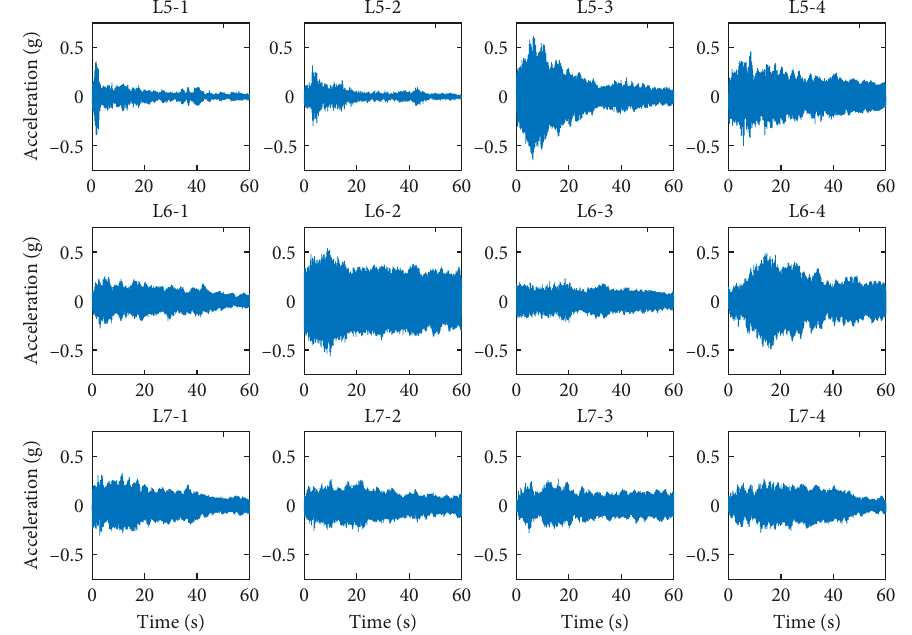
Figure 12: Acceleration time histories.